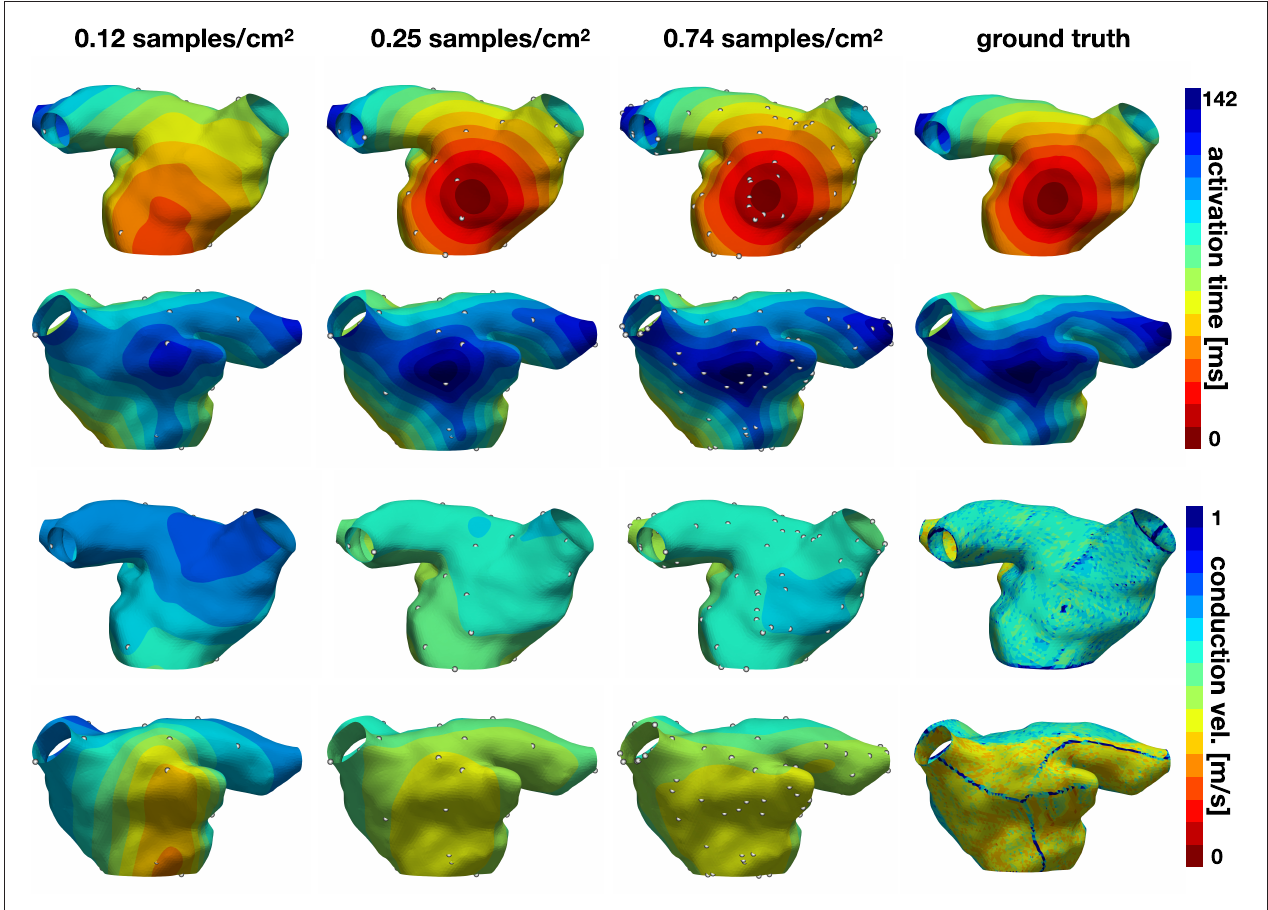
FIGURE 9 | Evolution of active learning for the heterogeneous case with partly reduced conductivity. The top two rows show the activation times for different sample densities and the ground truth for two different views. The bottom rows represent the conduction